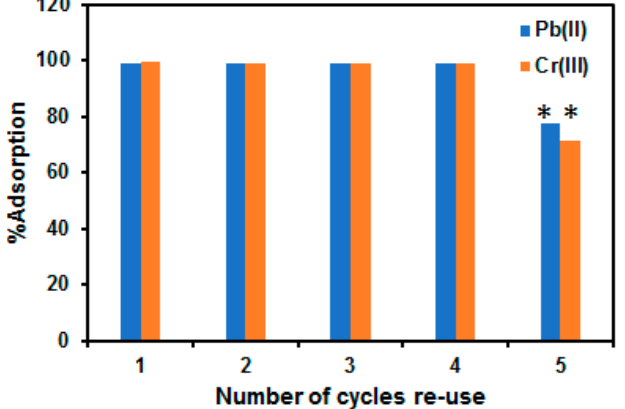
Figure 9. The recycling and reuse studies of the rGONF loaded with Pb(II) and Cr(III). ** indicates significant changes in the adsorption percentage of the metal ions.